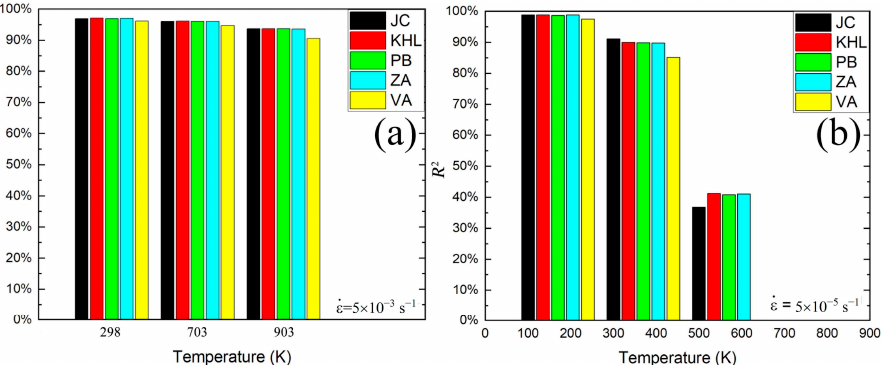
Figure 15. Comparison of different constitutive models under different temperatures at the high and low strain rates. ( a ) 5 × 10 − 3 s − 1 . ( b ) 5 × 10 − 5 s − 1